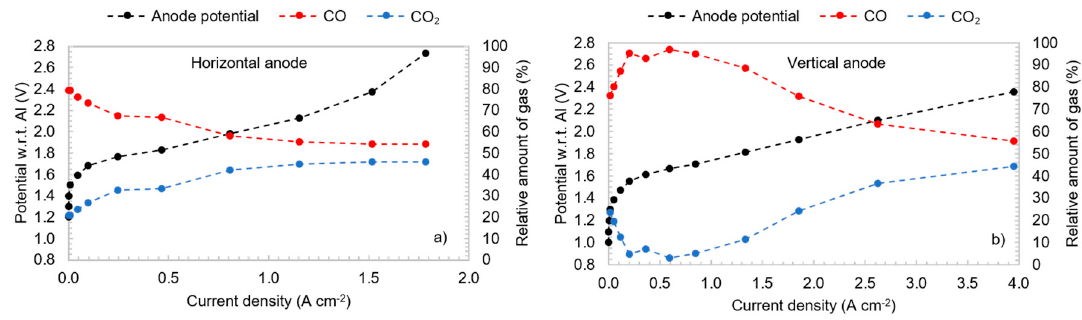
Figure 11. Anode potential and relative amount of the CO and CO 2 gas for the ( a ) horizontal anode and ( b ) vertical anode versus current density.